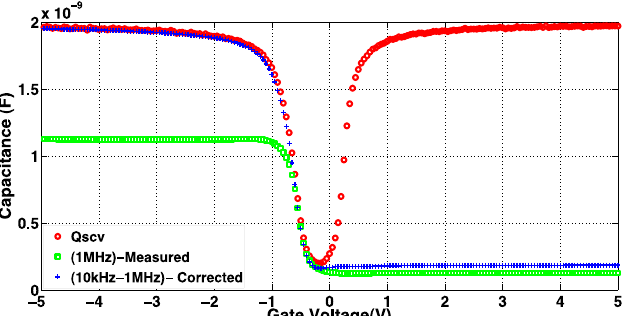
Fig. 3. Typical quasi-static (QSCV) and high-frequency (HF) C - V curves for a MIS capacitor with SiO 2 dielectric. The HF curve is also represented after parasitic free (frequency- dispersion related problems in accumulation gate voltages) cor- rection using “dual-frequency five-element small-signal circuit